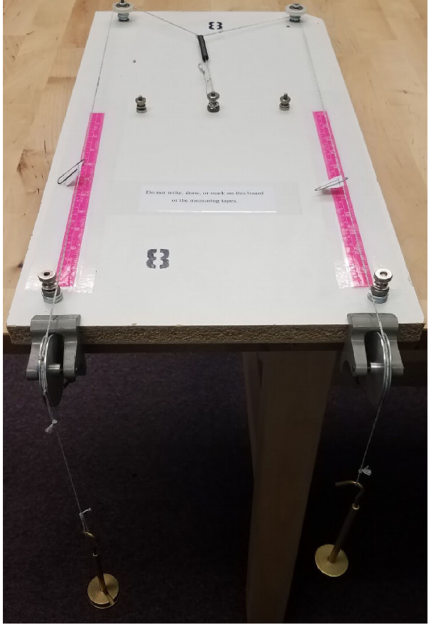
FIG. 1. The partial derivative machine, a mechanical analogue of thermodynamic systems used as a pedagogical tool.